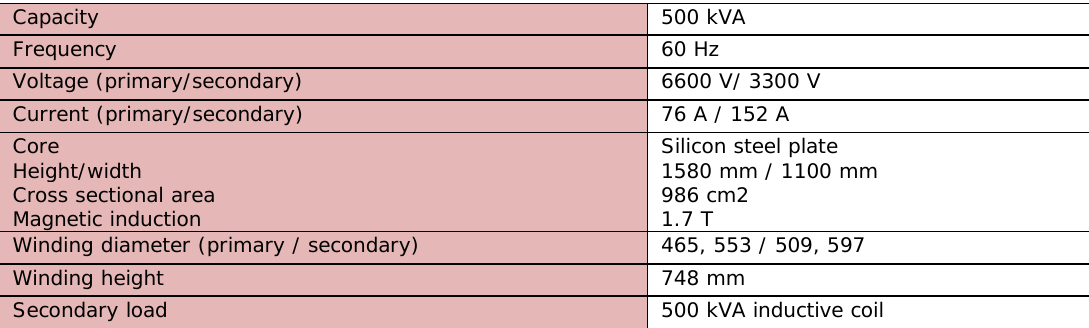
Table 4. “HTS Transformer design parameters”. Source: HTS transformer development in